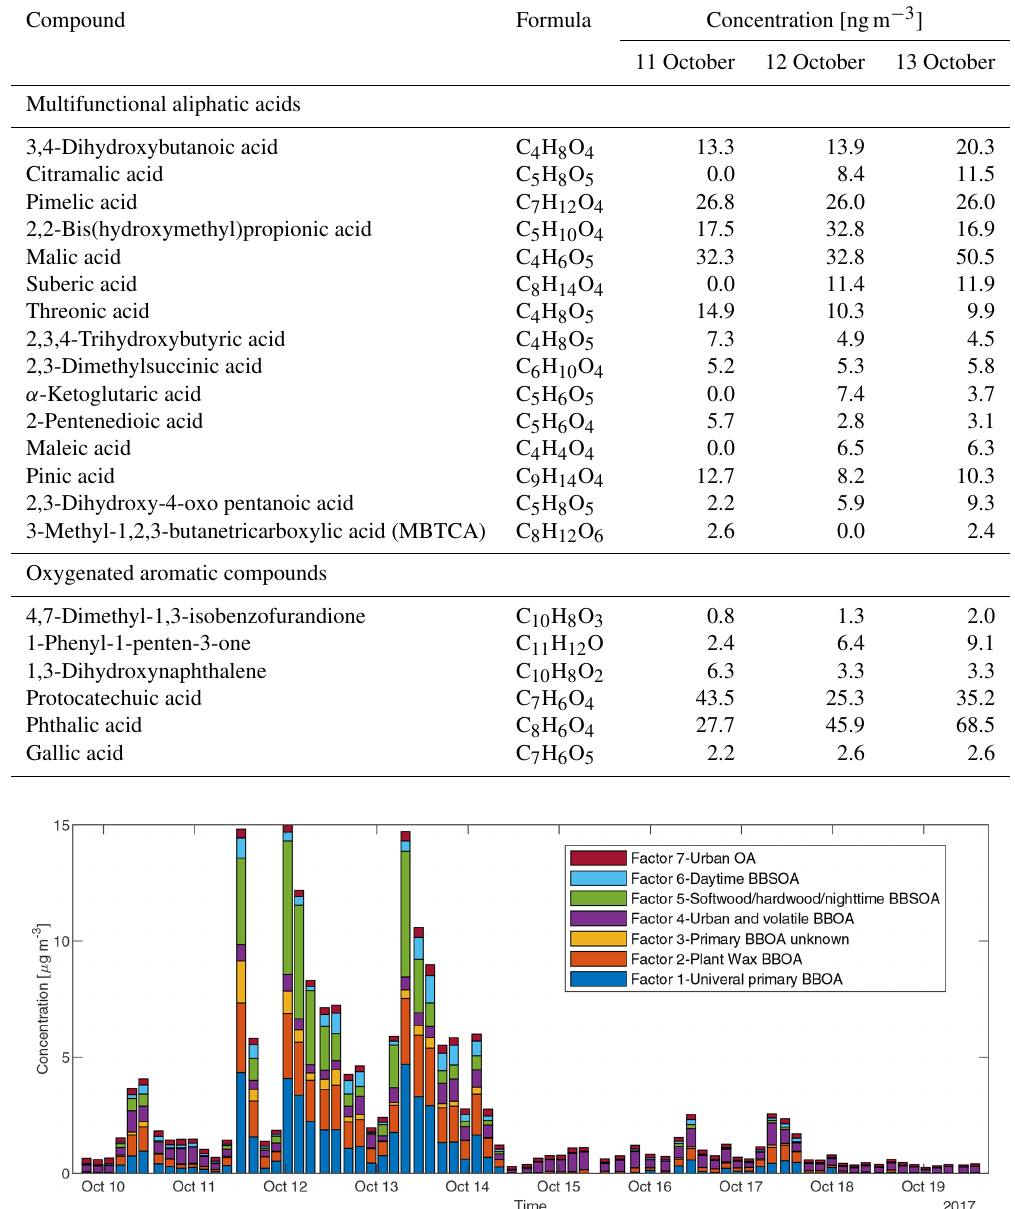
Table 2. Concentrations of selected positively identified compounds in factor 6 in the plumes on the afternoons of 11, 12, and 13 October. Compound Formula